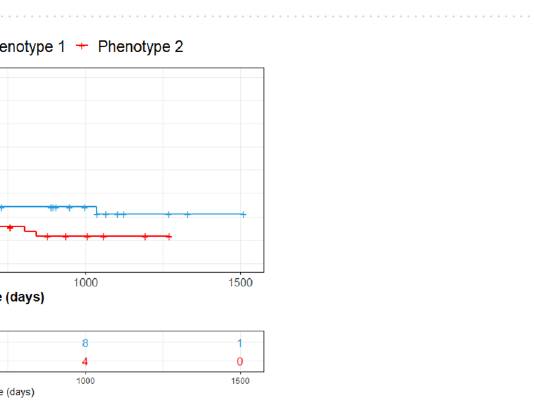
Figure 1. Heatmap of radiomic derived features (created using R programming language (ver. 3.5.1) https:// www.R- proje ct. org/). Unsupervised hierarchical clustering identifies two distinct, and statistically significant ( p = 0.02) tumor radiomic phenotypes. Association of these phenotypes with the clinical covariates is assessed by the Chi square test and the resultant p values are included in the figure.